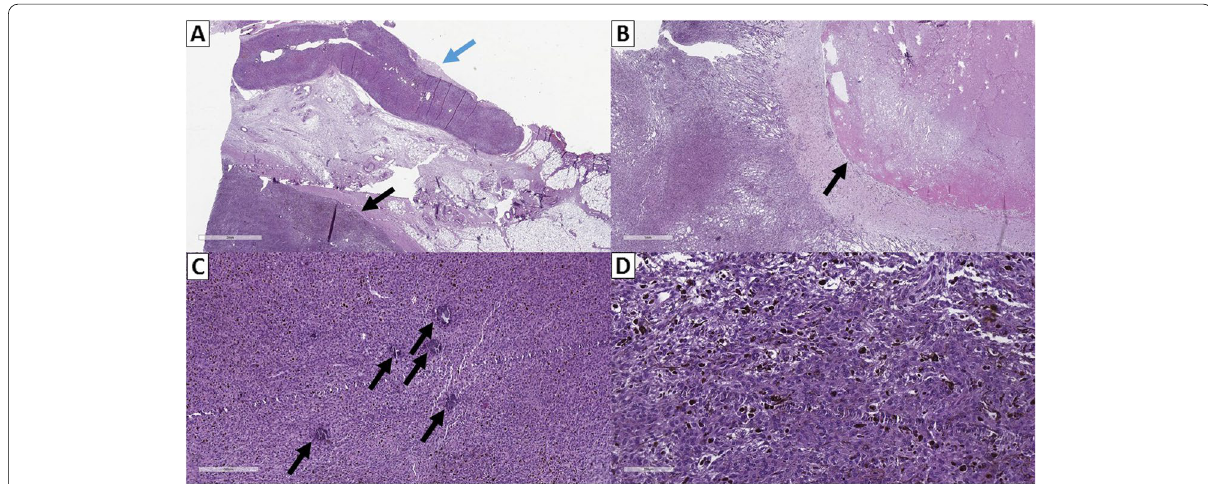
Fig. 5 A Tumor formation (black arrow) without connection to the adrenal gland (blue arrow), hematoxylin and eosin stain, original magnification 14 . B Large field of necrosis (arrow) in the central areа of the tumor, hematoxylin and eosin stain, original magnification 20 × body calcium aggregates (arrows) within the tumor parenchyma, hematoxylin and eosin stain, original magnification 80